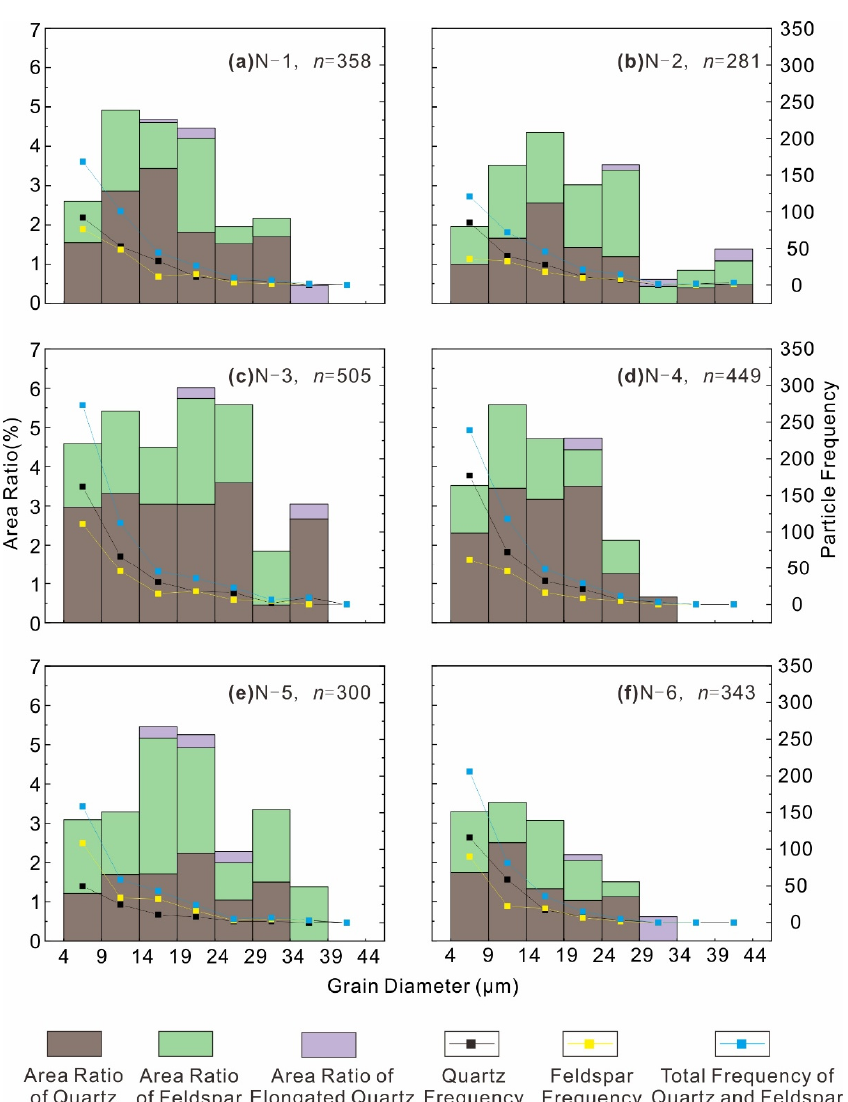
Figure 10. Area fractions and quantity distributions for detrital quartz and feldspar. ( a – f ) Statistical results of N-1, N-2, N-3, N-4, N-5 and N-6, respectively. The frequency is the corresponding result of unifying the measurement area to 100,000 μ m 2 , and the total frequency is rounded.